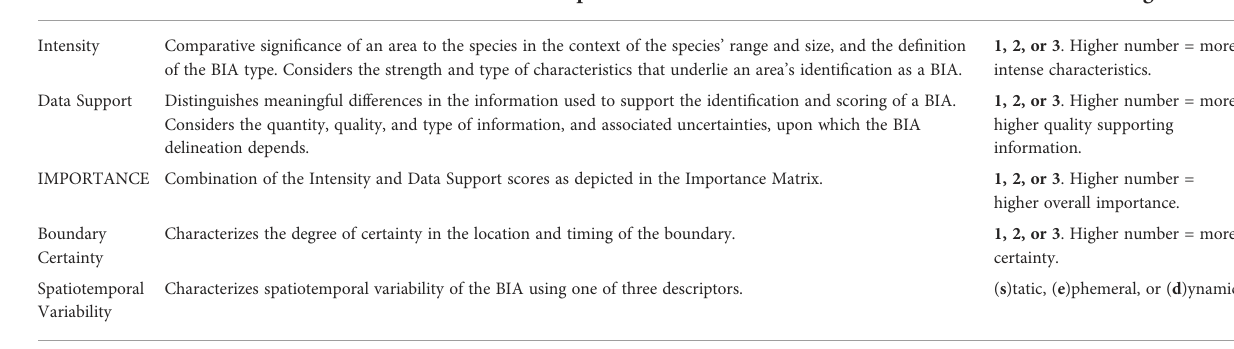
TABLE 2 Descriptions of the fi ve metrics used to score and label